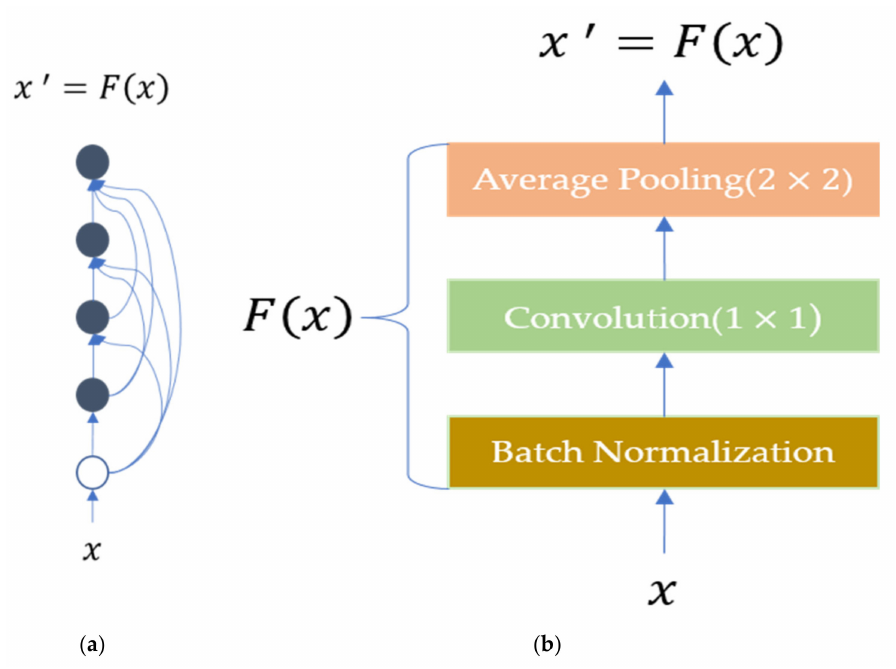
Figure 2. DenseNet ( a ) dense and ( b ) transition